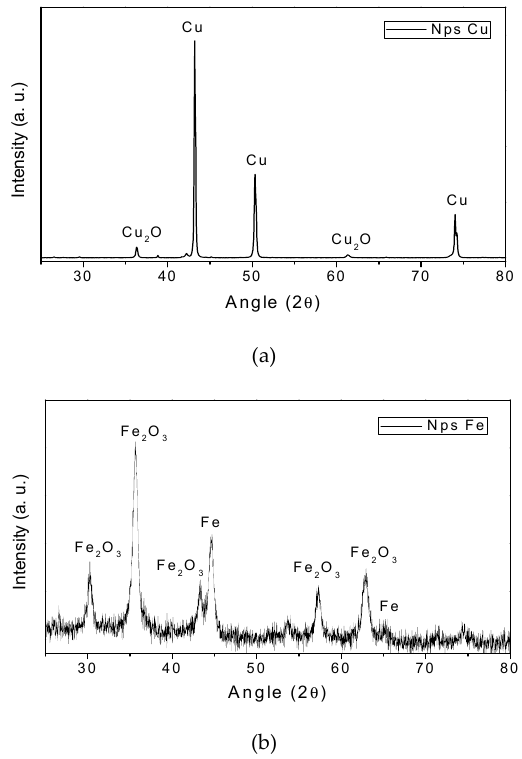
Figure 1. XRD patterns of the samples. ( a ) CuNPs; ( b ) FeNPs.